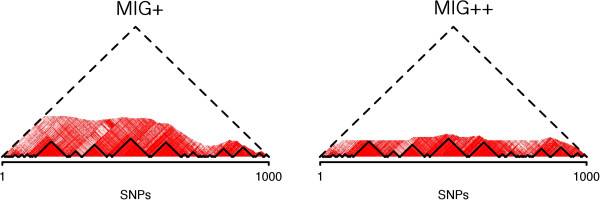
LD heatmap of region chr20:31,767,872-33,700,401, which contains 1,000 polymorphic SNPs in the HapMapII dataset. The area under the dashed line corresponds to all possible SNP pairs. The computed SNP-pair weights are indicated in red, with higher red intensity corresponding to higher |D′| values. The non-colored area corresponds to the SNP pairs omitted from computations. The solid line indicates the final haplotype block partition. It can be observed that, while the final block partition is identical for the two algorithms, more computations have been omitted by MIG + than MIG +.